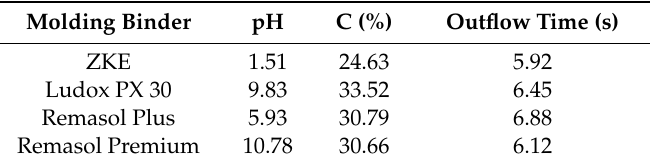
Table 3. Properties of polymeric binders.